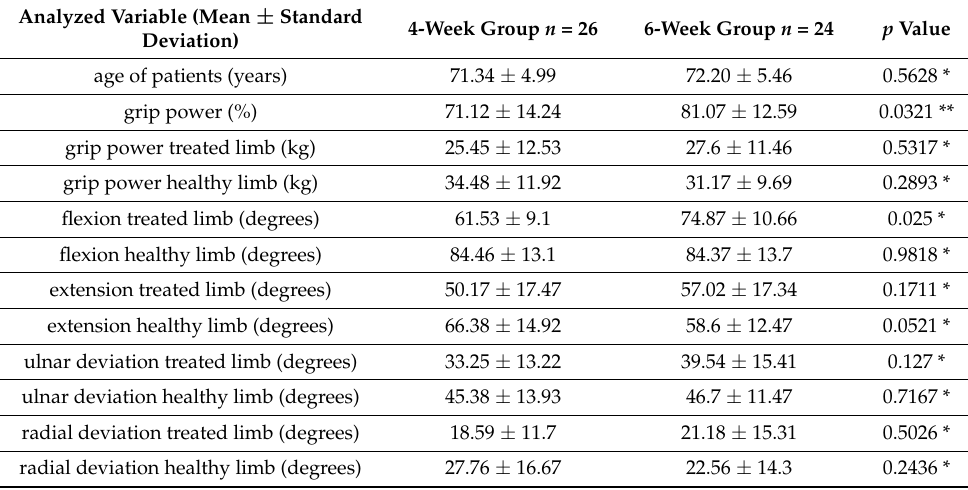
Table 1. Detailed results of the grip power and range of motion of individual subgroups. Analyzed Variable (Mean ± Standard